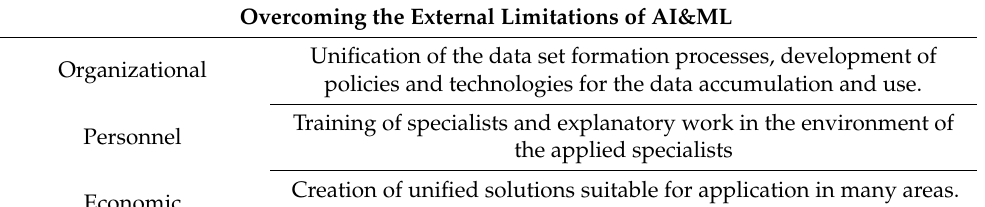
Table 3. Directions of research oriented towards overcoming the limitations of AI&ML